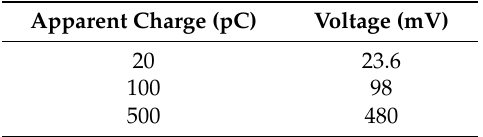
Table 1. Calibration apparent charge data for the applied PD generator oil cell.